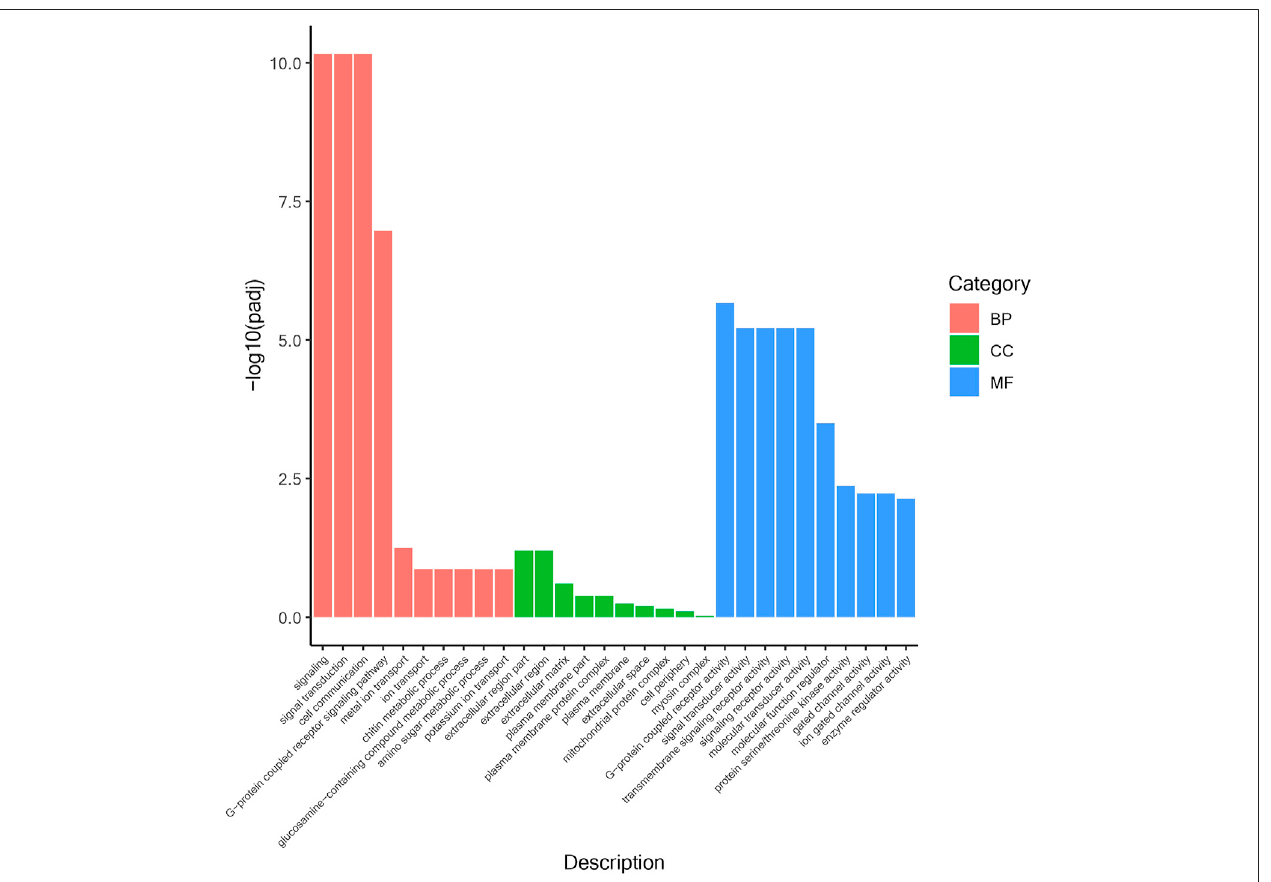
FIGURE 1 | GO enrichment analysis of salt-alkali tolerance candidate